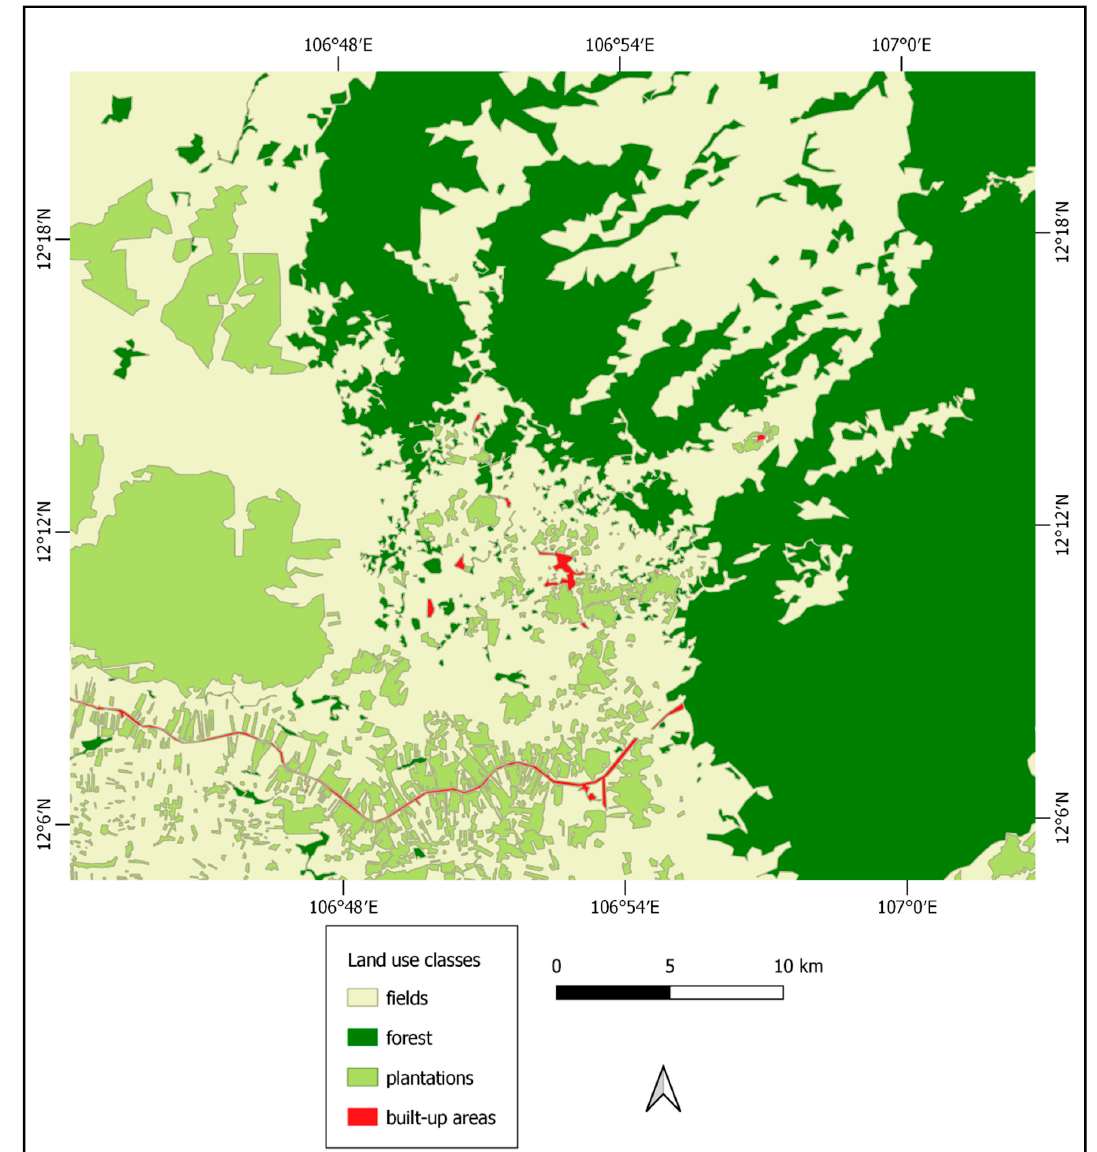
Figure 6. Land use map from 2018 SPOT 6/7 satellite imagery.